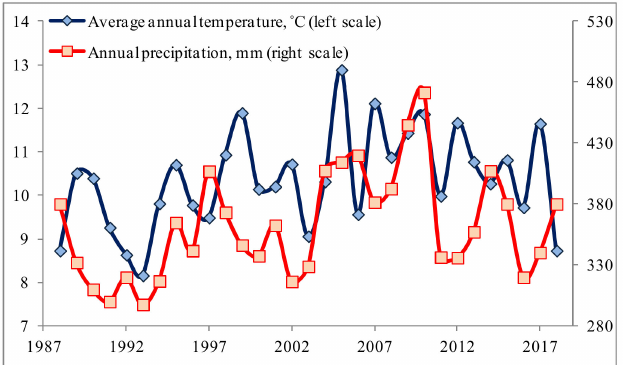
Figure 2. Dynamics of average annual temperature and annual precipitation: x -axis is a sequence of years, y -axis is average yearly temperature, left scale is average annual temperature in ◦ C and right scale is annual precipitation in